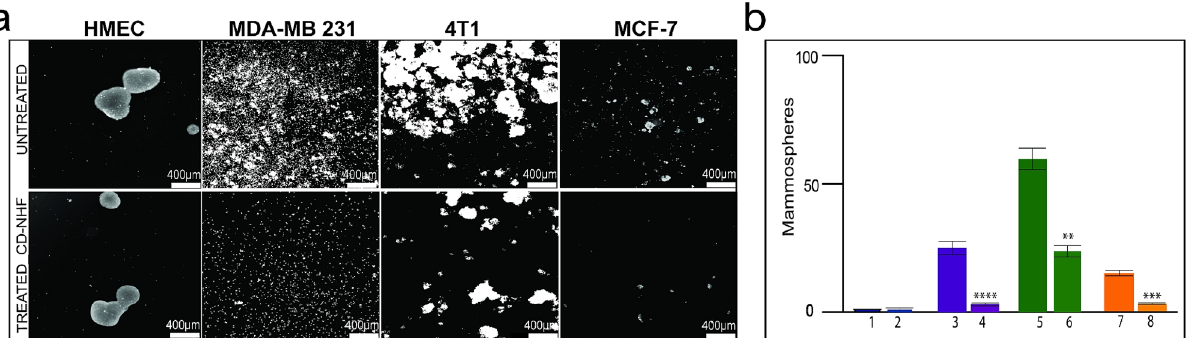
Figure 3. Effect of CD-NHF in Mammosphere assay. A . Morphologic aspects. a,b HMEC; c,d MDA-MB-231; e,f 4T1; g,h MCF7. B . Mammosphers quantification 1,2 Normal mammary cells (HMEC, Mcf-10a) (1-untreated, 2-treated with 5% CD-NHF); 3,4 MDA-MB231 (3-untreated, 4-treated with 5% CD-NHF); 5,6 4T1 (5-untreated, 6-treated with 5% CD-NHF); 7,8 MCF7 (7-untreated, 8-treated with 5% CD-NHF ).10 ×,